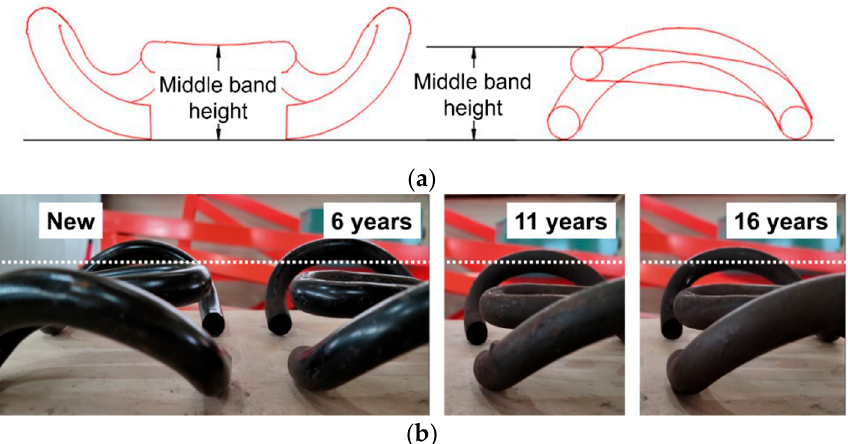
Figure 6. Schematic of deformation measurement for a middle-band tension clamp. ( a ) Measuring position of the middle-band height; ( b ) Deformation of the middle-band tension clamp according to the number of service years.